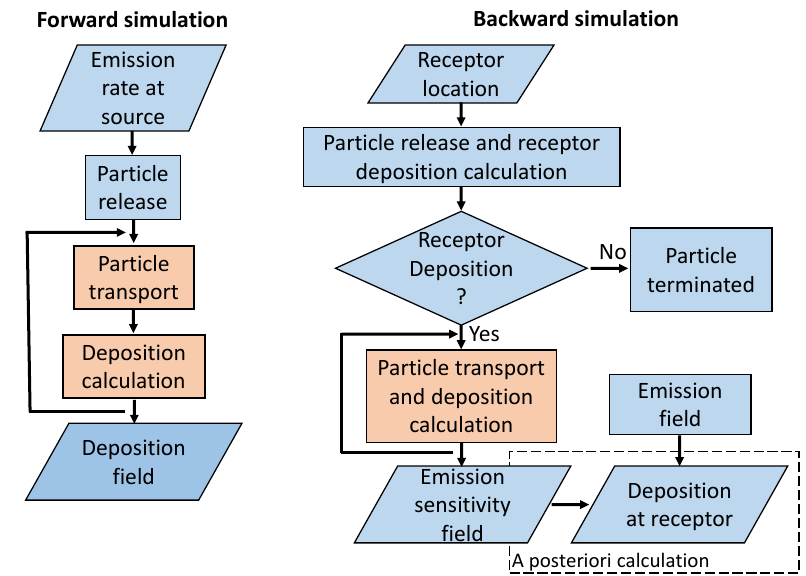
Figure 1. Flowchart comparing FLEXPART’s forward and backward mode for deposition calculations. In the backward mode, particles that do not undergo deposition at the receptor do not contribute to the emission sensitivity and are terminated immediately. This occurs for example for wet deposition if there is no precipitation occurring at the receptor. The calculations in the reddish boxes are done many times and with short time